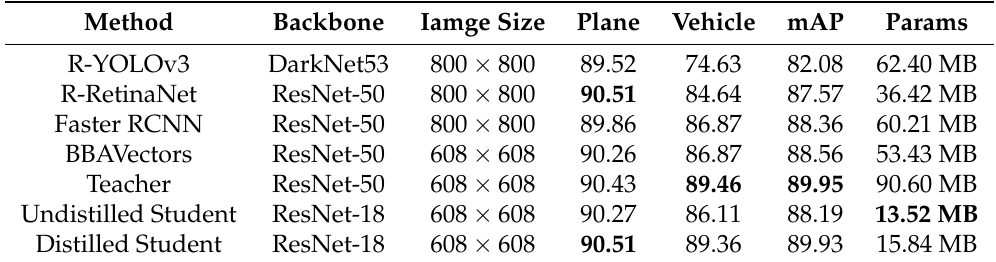
Table 2. Overall performance evaluation of different methods on UCAS-AOD datasets. Bold numbers in the table mean the best results.